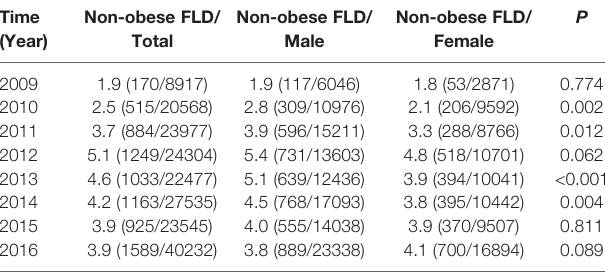
TABLE 1 | Prevalence of non-obese FLD in physical examinants from 2009 to 2016